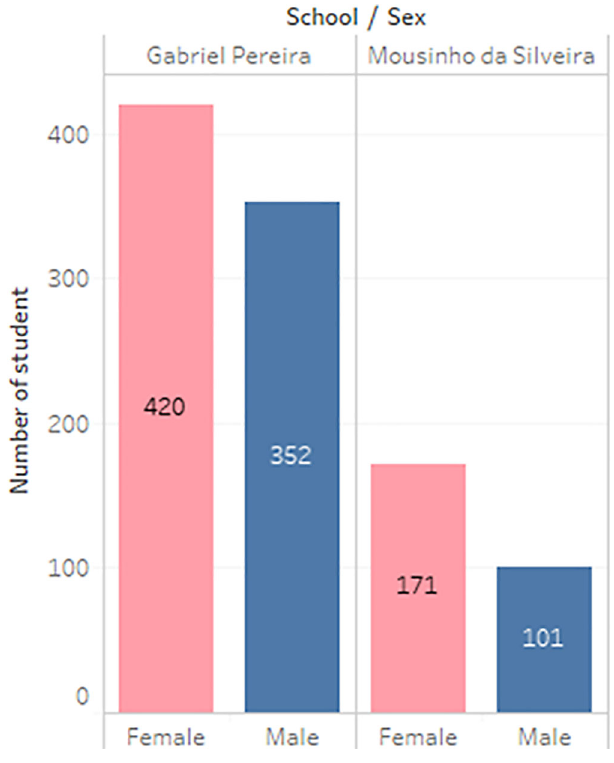
Figure 3. Distribution of